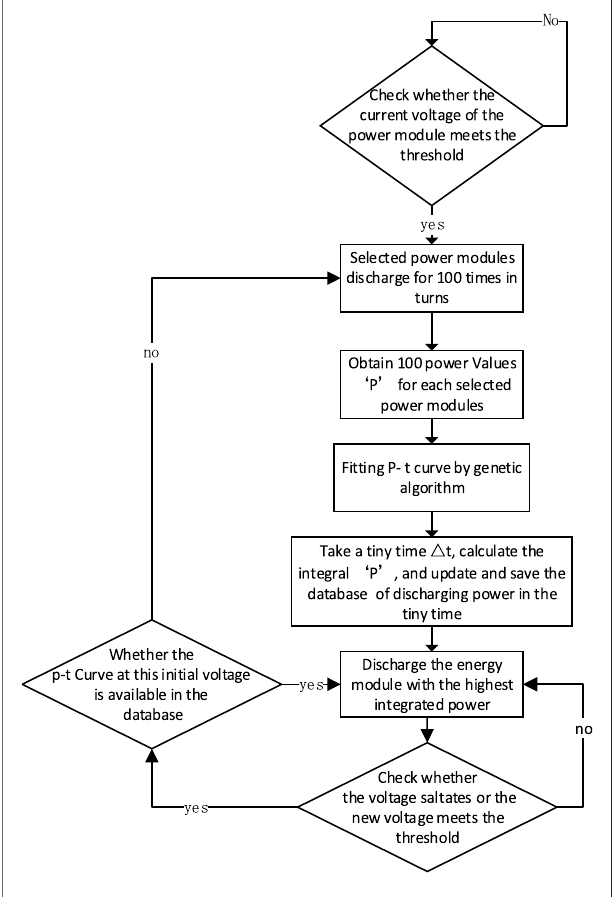
FIGURE 13 | Flow diagram of the maximum power control strategy based on power trajectory